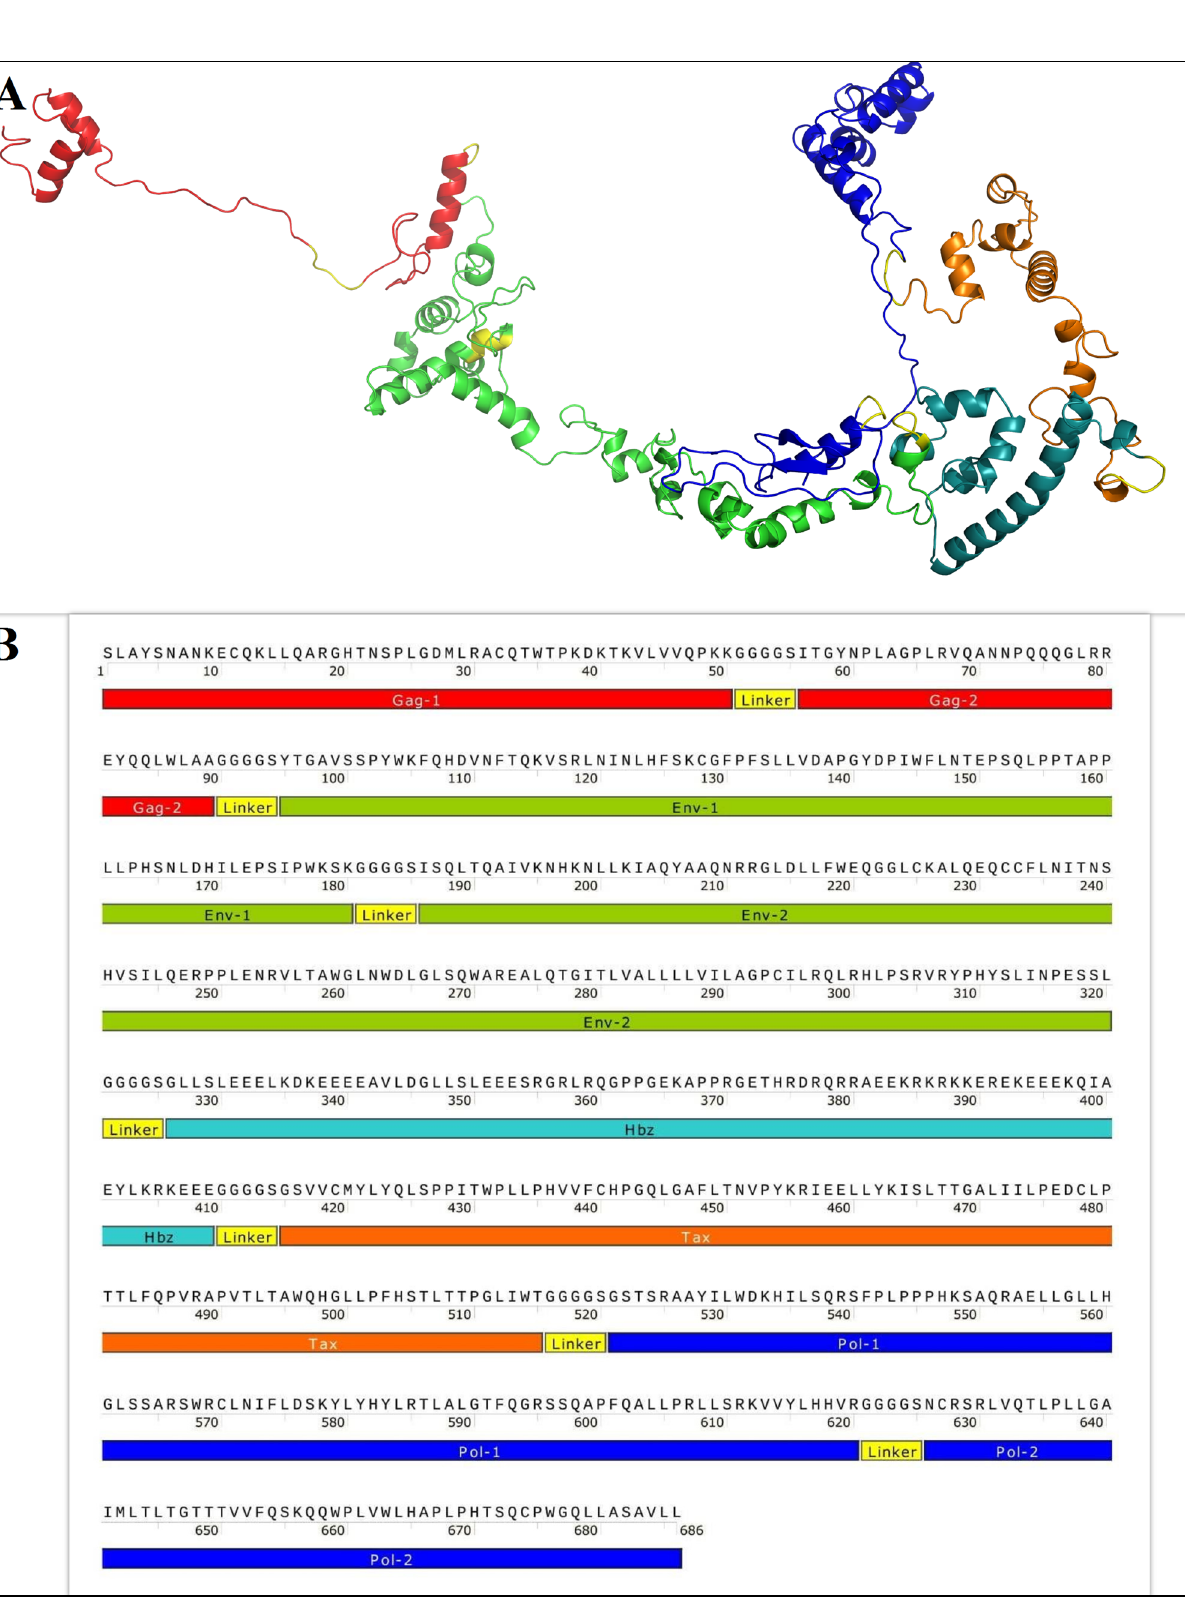
Figure 1. ( A ) The tertiary structure of the GPEHT protein. ( B ) A schematic diagram of the final construct of the vaccine candidate